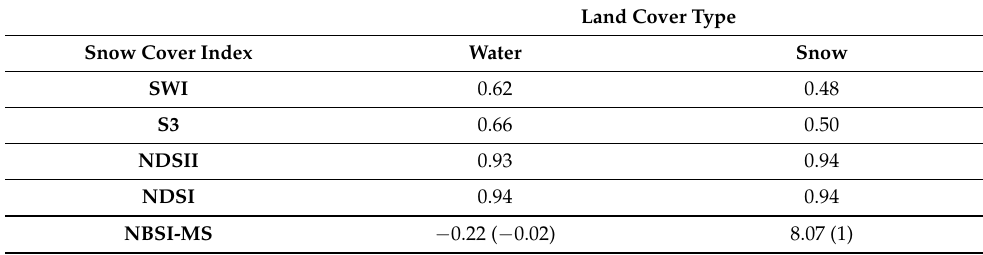
Table 6. The mean index values of one hundred pixels of water and snow taken from the Snow-Cover Indices maps for the Greenland region. Note: The NBSI-MS normalized values are in parentheses.